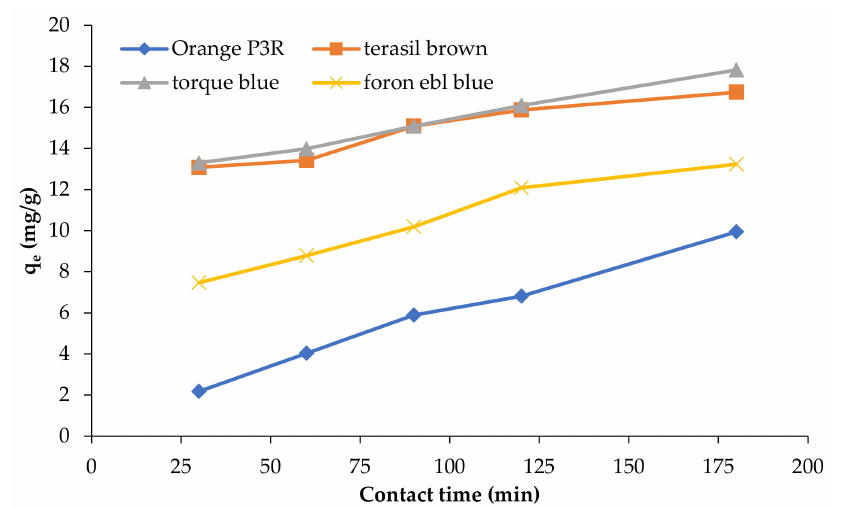
Figure 10. Effect of contact time on adsorption capacity (q e ) of composite materials for dye